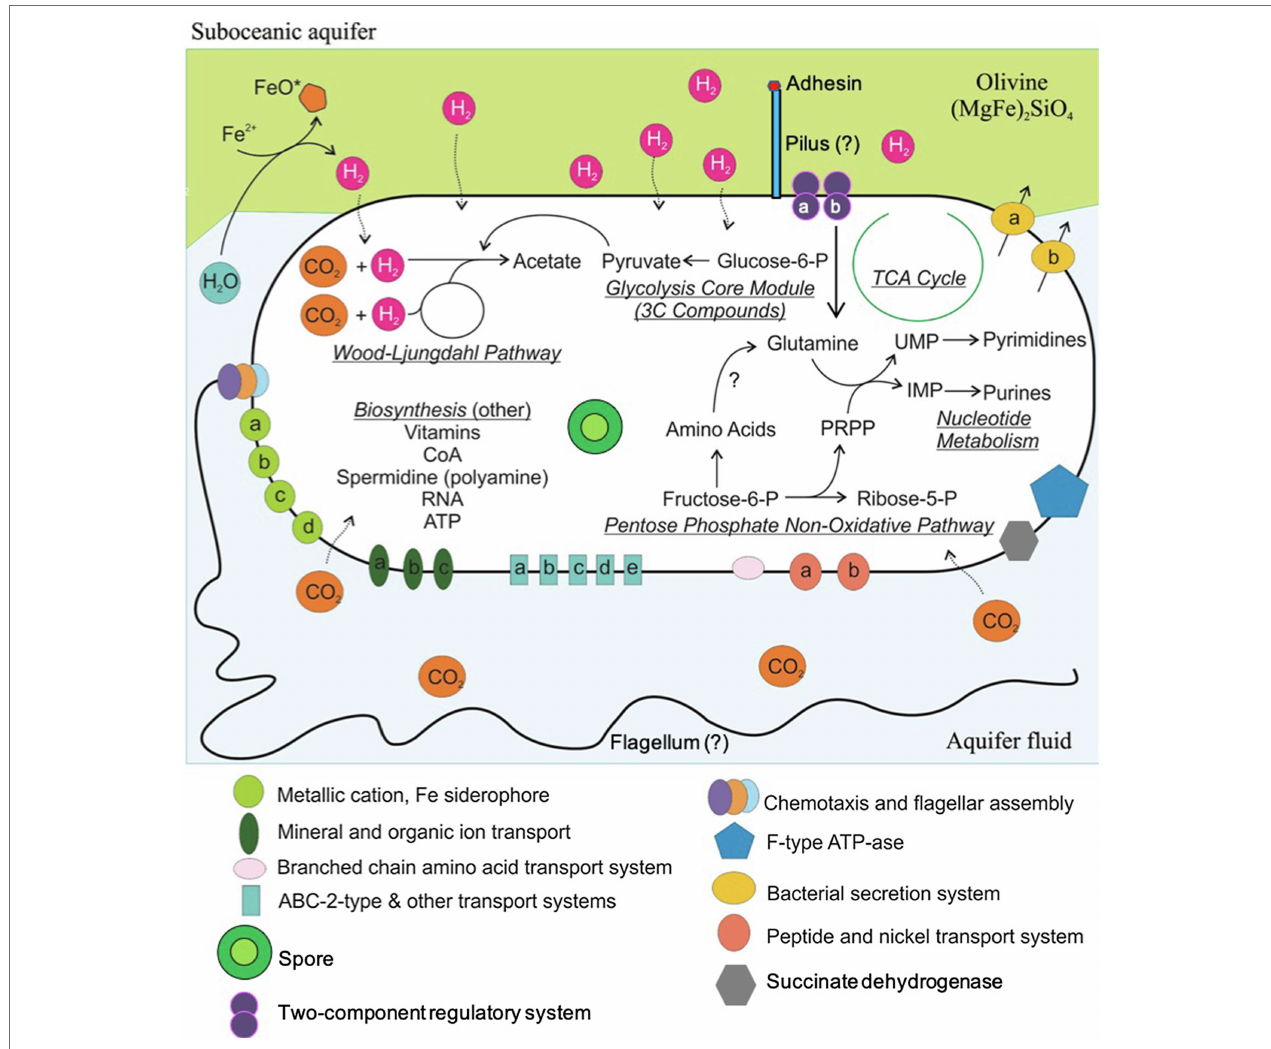
FIGURE 5 | Metabolic pathways of Ca. A. pyornia. This organism contains the complete Wood–Ljungdahl pathway for carbon fixation, hydrogenases, and no carbohydrate or lipid importers. It is predicted that this organism is able to take advantage of hydrogen production on Fe 2+ -bearing minerals like olivine as they react with seawater. Hydrogen and bicarbonate can be funneled into the Wood–Ljungdahl pathway to produce acetyl-CoA for biosynthesis and energy. This organism is missing many amino acid synthesis pathways and likely needs to import these for biosynthesis or energy. Individual transport or regulatory systems pathways (denoted by lower case letters here) are listed in Tables 2 – 4 and Supplementary Tables 1 – 3 under the headings that match the labels in this